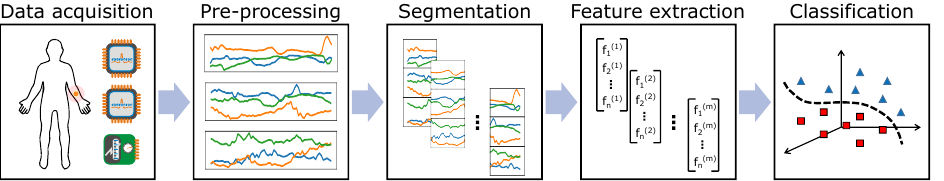
Figure 1. Pattern recognition chain including several steps that should be optimised in parallel to yield the best